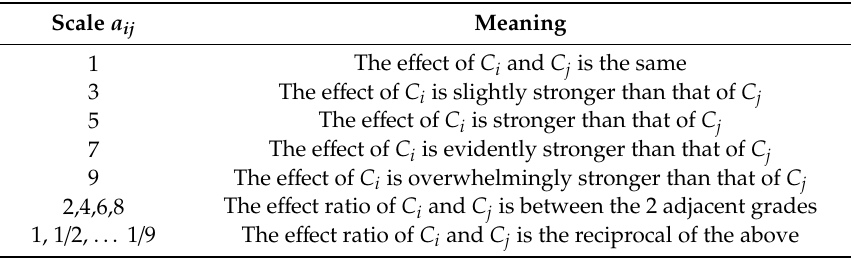
Table 4. 1–9 scale of the meaning of a ij .